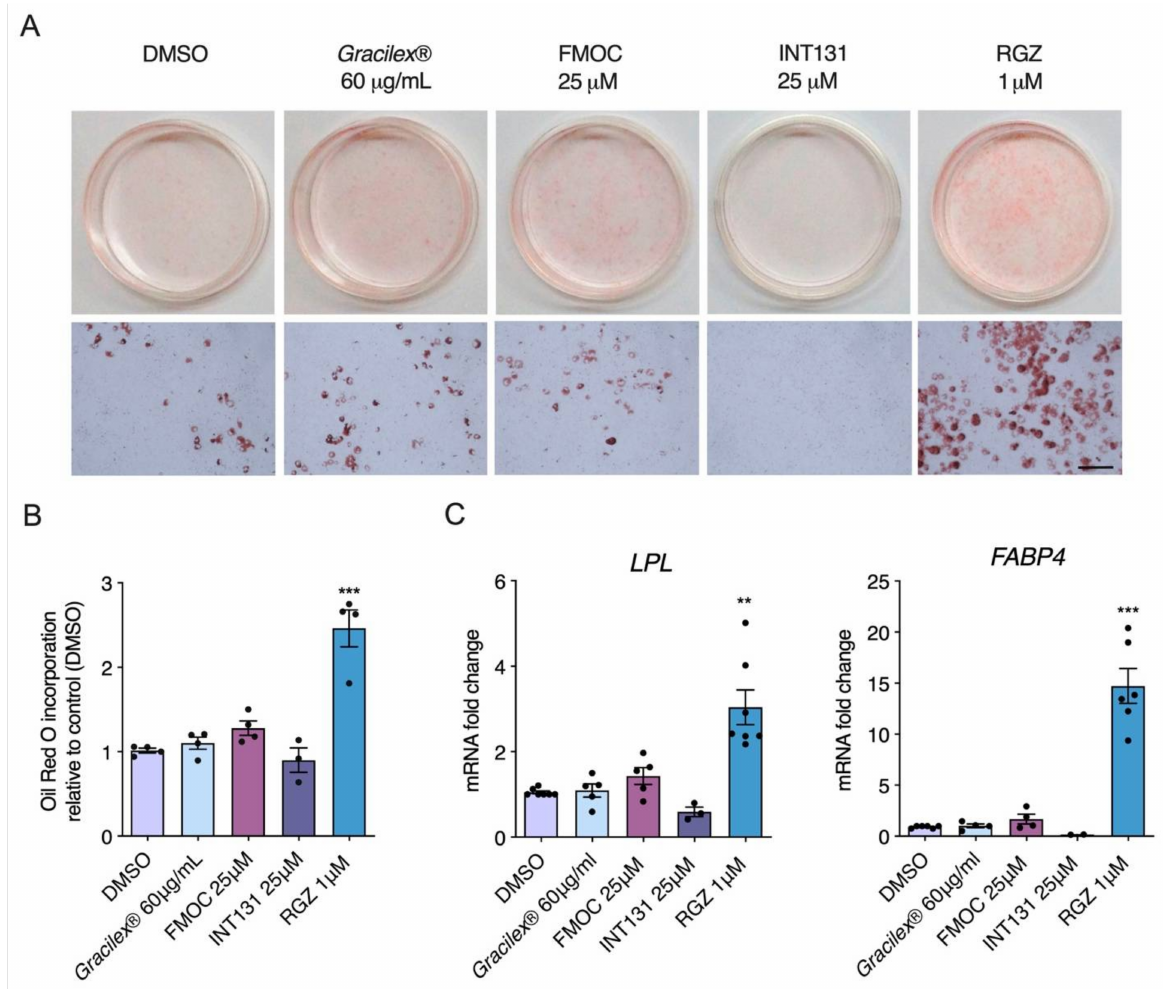
Figure 2. Adipogenesis in 3T3-L1 cells induced by rosiglitazone but not Gracilex ® or PPAR γ SPPARMs, FMOC-Leu (FMOC), and INT131. First, ( A ) 3T3-L1 preadipocytes were cultured with or without PPAR γ agonist FMOC-Leu and INT131 (25 µ M), rosiglitazone (RGZ, 1 µ M), and Gracilex ® (60 µ g/mL) as specified in the methodology section. After 10 days of culture initiation, cells were stained with Oil Red O to label triglycerides, and the plates were photographed. Upper panels: microphotography of 35 mm plates. Lower panels: higher magnification of differentiated adipocytes stained with Oil Red O. Scale bar, 50 µ m. The ( B ) quantification of Oil Red O incorporation was measured after cell lysis with isopropanol at a wavelength of 490 nm. Values are expressed as mean relative to that of control cells (treated with DMSO) ± SEM, n = 6, *** p < 0.001 (one-way ANOVA and Tukey’s post hoc test). The ( C ) effects of Gracilex ® and PPAR γ agonists on expression of lipogenic pathway-related genes during differentiation process of mouse 3T3-L1 preadipocytes were measured after 7 days of culture initiation, as indicated in the methodology section. After treatment with each compound, cells were lysed and mRNA levels of LPL and FABP4 genes were measured by qPCR. The graph shows the relative abundance compared to the control (untreated cells, control DMSO). Values are expressed as the mean relative to that of control cells (treated with DMSO) ± SEM, n = 4, ** p < 0.01, *** p < 0.001 (one-way ANOVA and Tukey’s post hoc